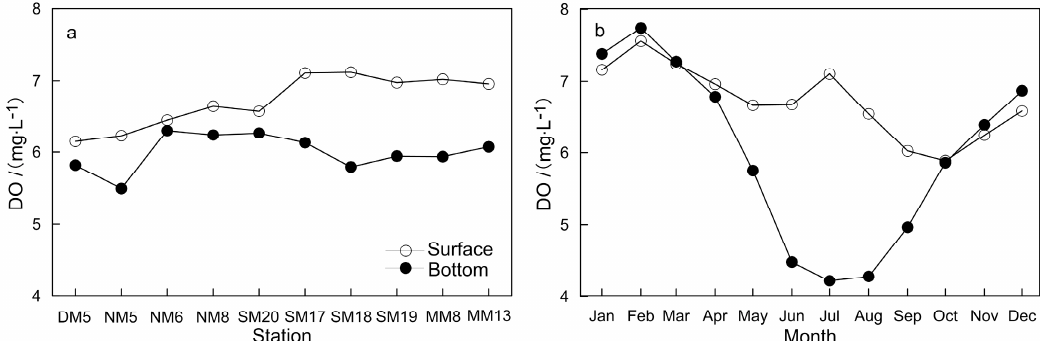
Figure 5. Variability of DO during the period 2000 − 2017. ( a ) Annual average at each station; ( b ) monthly average at all stations.